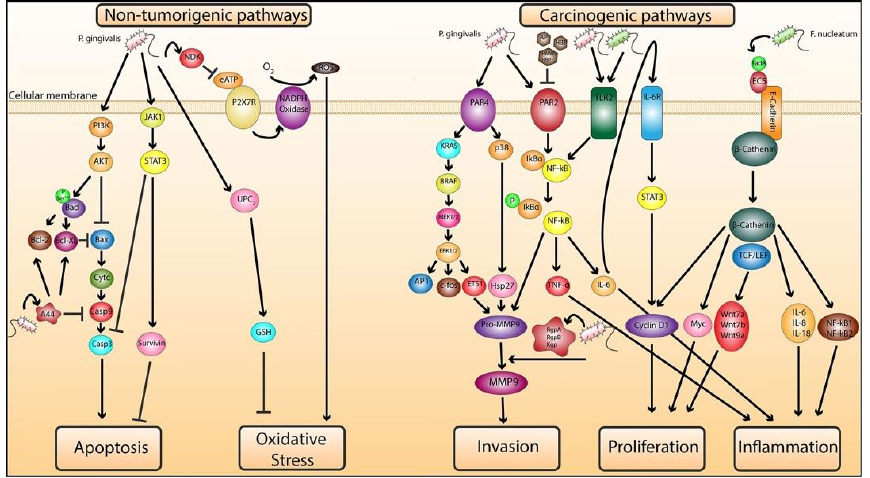
Figure 1. Proposed molecular mechanisms of P. gingivalis and F. nucleatum -mediated tumorigenesis in tumorous and nontumorous cells. Nontumorigenic pathways: ( left ). P. gingivalis promotes an- tiapoptosis by activating JAK1/STAT3 and PI3K/AKT prosurvival signaling pathways to inhibit caspase3 (casp3) and activate survivin. P. gingivalis -mediated activation of PI3K/AKT leads to the phosphorylation of Bad at serine residue 136 and its activation results in its dissociation from an- tiapoptotic Bcl2 and Bcl-XL proteins, which enhances the antiapoptotic effect of the Bcl2 family reflected by the inhibition of apoptotic protein Bax. Furthermore, Bcl-2 and Bcl-XL are upregulated by P. gingivalis gigipain’s adhesin peptide A44, which also inhibits Casp9 activation at early stages. Inhibition of Bax impedes cytochrome c (cytc) release from the mitochondria and blocks the cleavage of casp9 and subsequent activation of effector caspase3, which obstructs the mitochondrial intrinsic apoptotic pathway. P. gingivalis inhibits P2X7 receptor (P2X7R)/NADPH oxidase-mediated ROS production and subsequent apoptosis by blocking extracellular ATP (eATP) ligation to P2X7R through its ATP-scavenging enzyme, nucleoside diphosphate kinase (NDK). Additionally, P. gingivalis induces antioxidant responses by increasing glutathione (GSH) levels intracellularly possibly by upregulating the uncoupling protein 2 (UCP2). Carcinogenic pathways: ( right ). P. gingivalis activates protease- activated receptor 4 (PAR4), which in turn activates the ERK1/2/Ets1 and p38/Hsp27 pathways resulting in pro-MMP9 production. P. gingivalis ’s activation of PAR2 can mediate pro-MMP9 pro- duction via the NF-kB pathway. The cleaved active form of pro-MMP9 is MMP9. Metalloproteinase (MMP) families are involved in ECM and basement membrane degradation and enhance invasion in neoplastic cells. P. gingivalis through its virulent factor, a cysteine protease termed gingipain, can cleave pro-MMP9 into its active form MMP9. Gingipains consist of arginine-specific protease A (RgpA) and B (RgpB) and a lysine-specific protease (Kgp), which are responsible for the cleavage of pro-MMP9 into MMP9. Apple polyphenol (AP), hop bract polyphenol (HBP) and high-molecular weight HBP (HMW-HBP) are polyphenols that can inhibit the proteolytic activity of gingipains and can inhibit the PAR2/NF-kB release of pro-MMP9. Thus, P. gingivalis promotes invasion through gingipain-mediated activation of MMP9. F. nucleatum ’s virulent factor FadA binds to the extracellular domain 5 (EC5) of E-cadherin receptor and activates β -catenin that stimulate cyclin D1 and Myc upregulation and binds to T-cell factor/lymphoid enhancer factor (TCF/LEF) to stimulate the secre- tion of Wnt7a, Wnt7b and Wnt9a, all of which promote cellular growth and proliferation. β -catenin enhances the production of cytokines IL-6, IL-8 and IL-18 and NF-kB1/2 and promotes inflammation, an optimal microenvironment for the prosperity of cancerous cells. F. nucleatum and P. gingivalis can activate toll-like receptor 2 (TLR2) and mediate TNF- α and IL-6 cytokine production via the TLR2-NF-kB pathway. IL-6 stimulates the activation of the IL-6 receptor (IL-6R), which in turn activates STAT3, known to ultimately upregulate the production of cyclin D1 and promote cellular